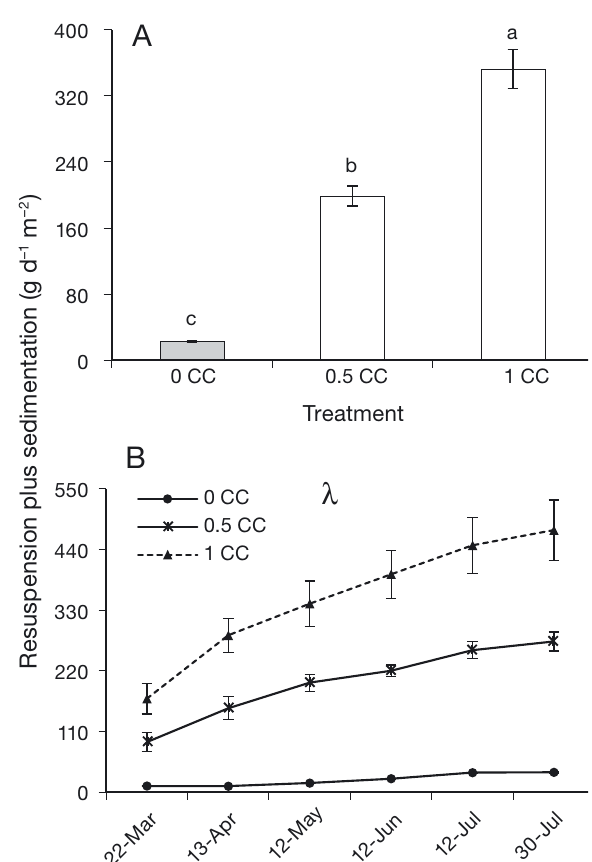
Fig. 4. (A) Mean resuspension and sedimentation at different stocking densities of common carp (CC; Cyprinus carpio) and (B) the interaction between time and common carp density on resuspension and sedimentation. Data are means (±SE). 0 CC, 0.5 CC and 1 CC indicate the ponds without common carp, with 0.5 common carp m −2 , and with 1 common carp m −2 , respectively. All treatments differ significantly (p < 0.01), as indicated by different superscript letters. λ indicates that the ponds without common carp, with 0.5 common carp m −2 , and with 1 common carp m −2 are significantly different from each other (p <